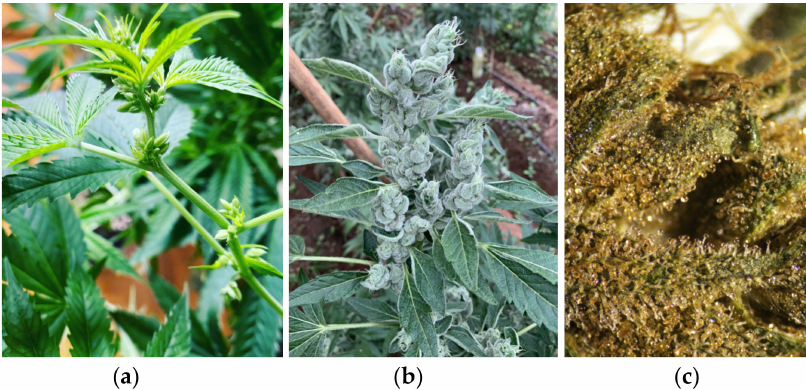
Figure 3. The cannabis staminate flowers ( a ) and pistillate flowers ( b ) with the trichome structures as the localization of cannabinoids and terpenes of Kees’ Old School Haze ® (available at https: // dutch-passion.com) ( c ). Table 1. Di ff erences between cannabis (marijuana) and hemp. Characteristics Cannabis (Marijuana) Hemp Genus Cannabis sativa L. Cannabis sativa L. Sub variety Indica